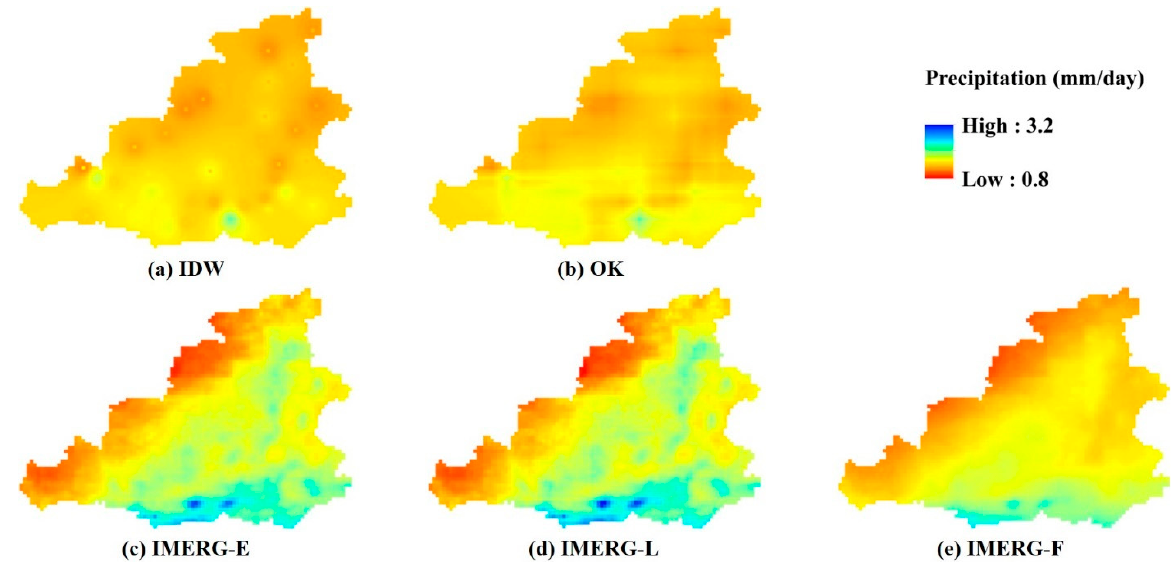
Figure 2. Spatial distribution of mean daily precipitation estimated from two interpolation methods and three IMERG SPPs from 1 January 2008 to 31 December 2019. and three IMERG SPPs from 1 January 2008 to 31 December